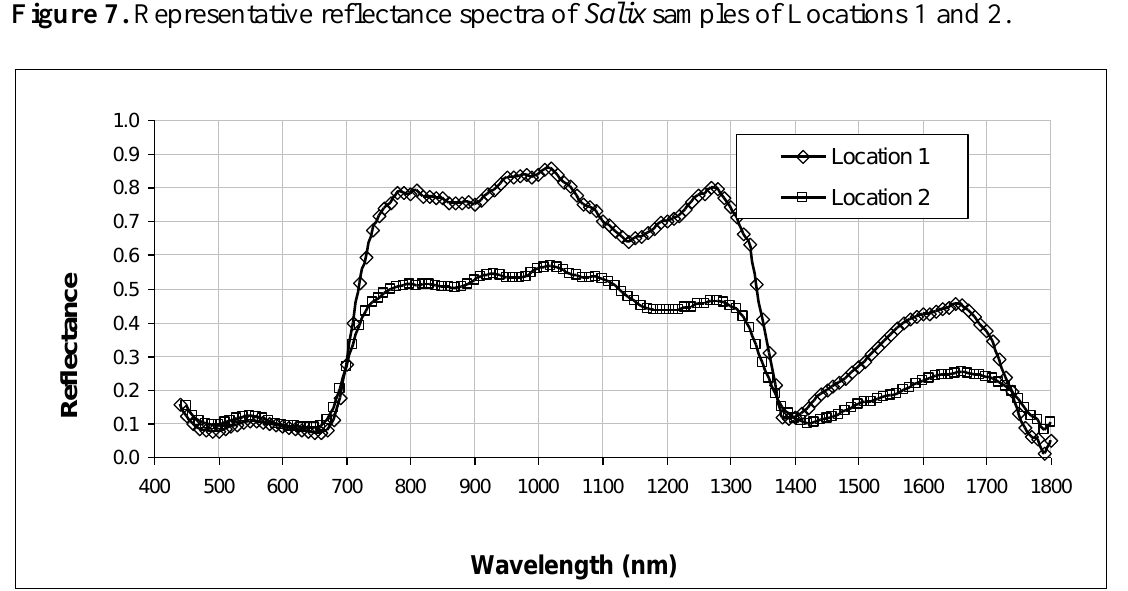
Figure 7. Representative reflectance spectra of Salix samples of Locations 1 and 2.